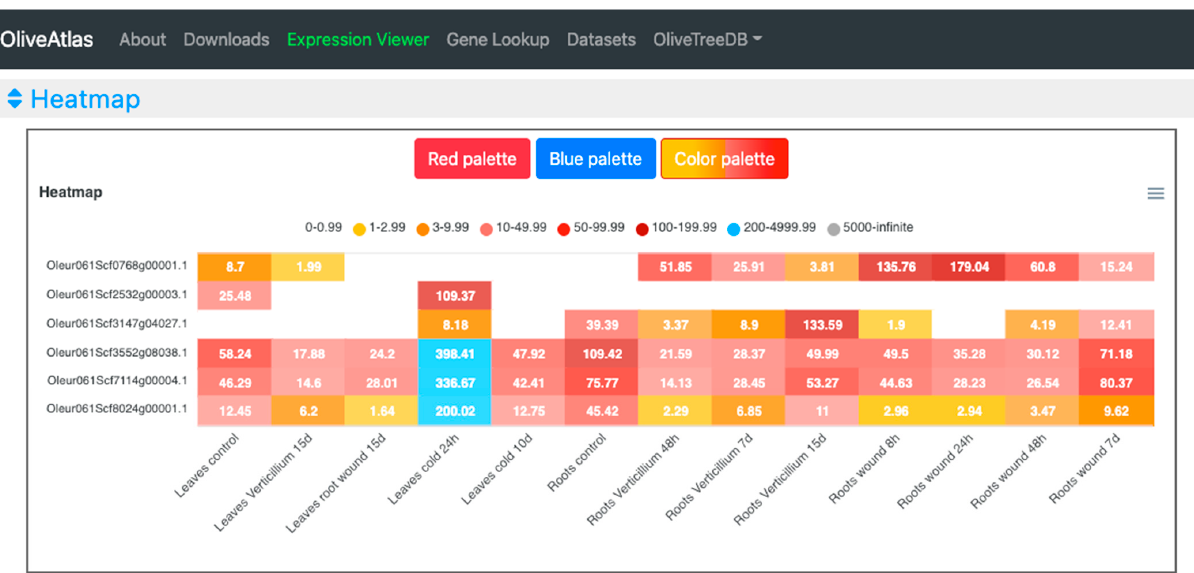
Figure 6. Heatmap visualization of the “Expression viewer” in OliveAtlas. Expression data are dis- played grouped by color in several ranges of expression. Three different color palettes are available.